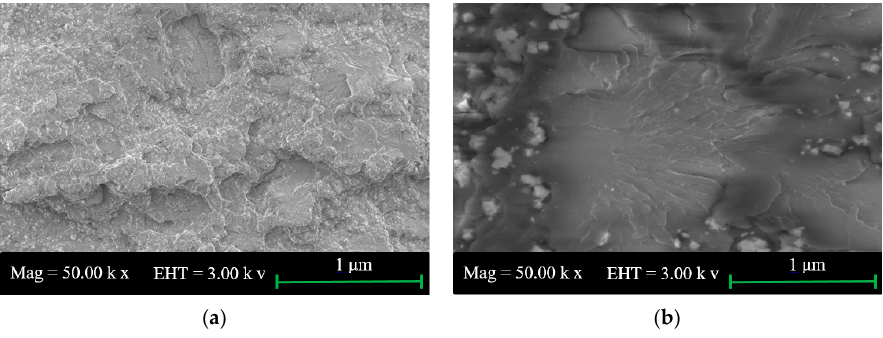
Figure 1. Scanning electron microscopy (SEM) microphotographs for ( a ) polyurethane (PU) and ( b ) starch.